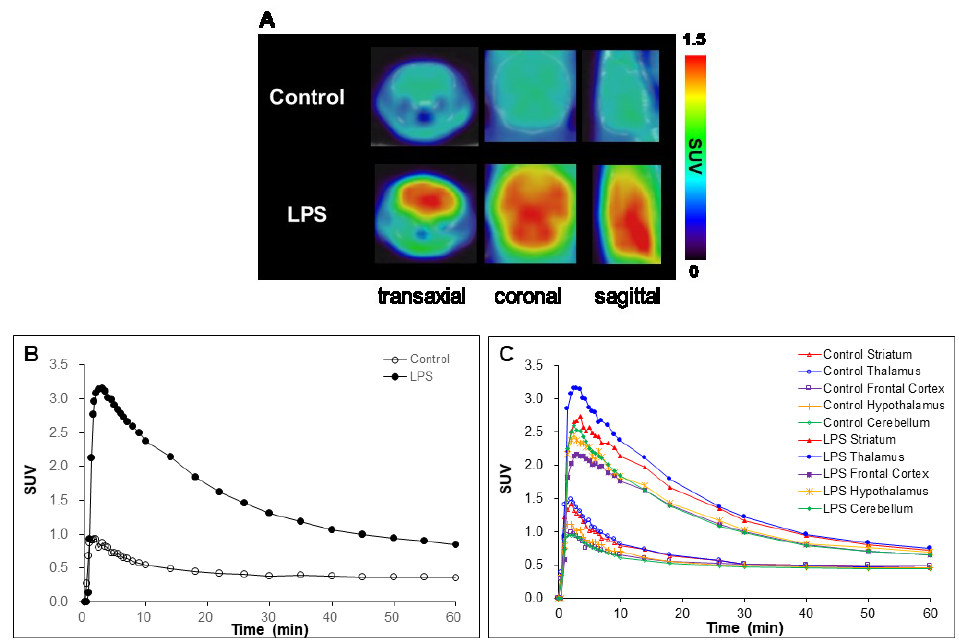
Figure 4. ( A ) Dynamic PET images of control and LPS mice acquired for 60 min after injection of [ 18 F] 1 ; ( B ) whole brain TACs of [ 18 F] 1 in control and LPS mice; ( C ) regional brain TACs of [ 18 F] 1 in control and LPS mice.